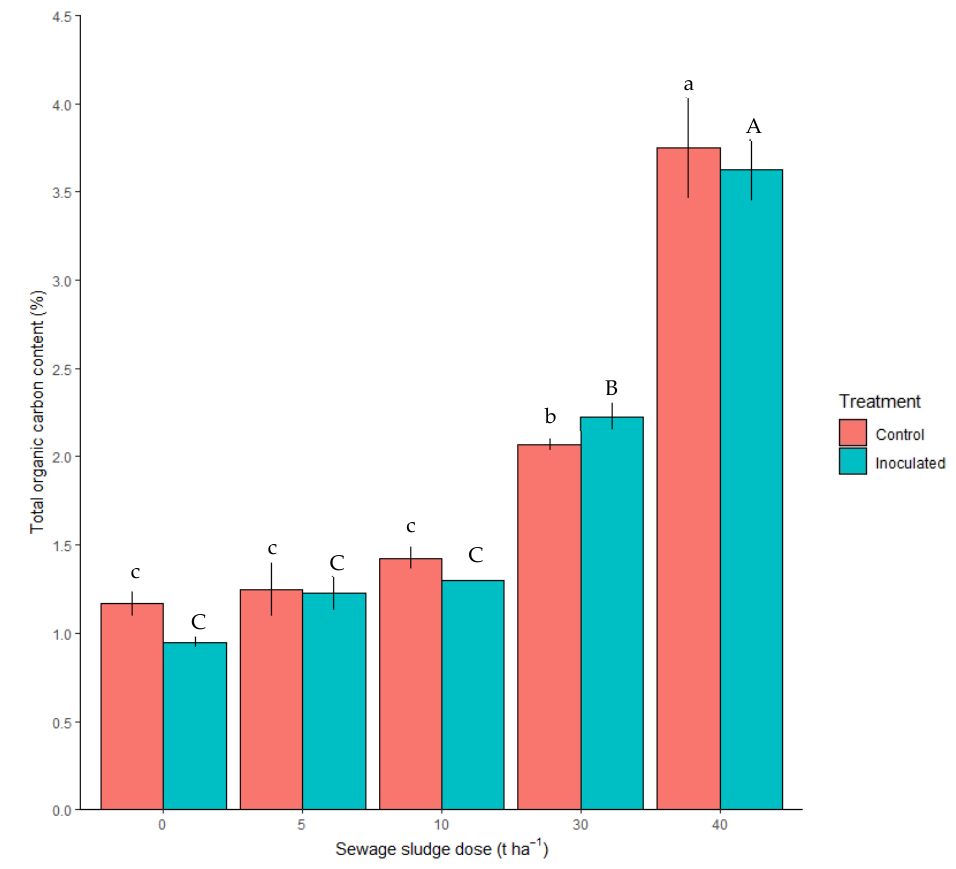
Figure 5. Organic carbon content (%) in the control and inoculated soils amended with the different SS doses, after 4 months. Lowercase letters indicate significant differences among control treatments at different SS doses, while capital letters indicate significant differences among inoculated treatments at different SS doses.